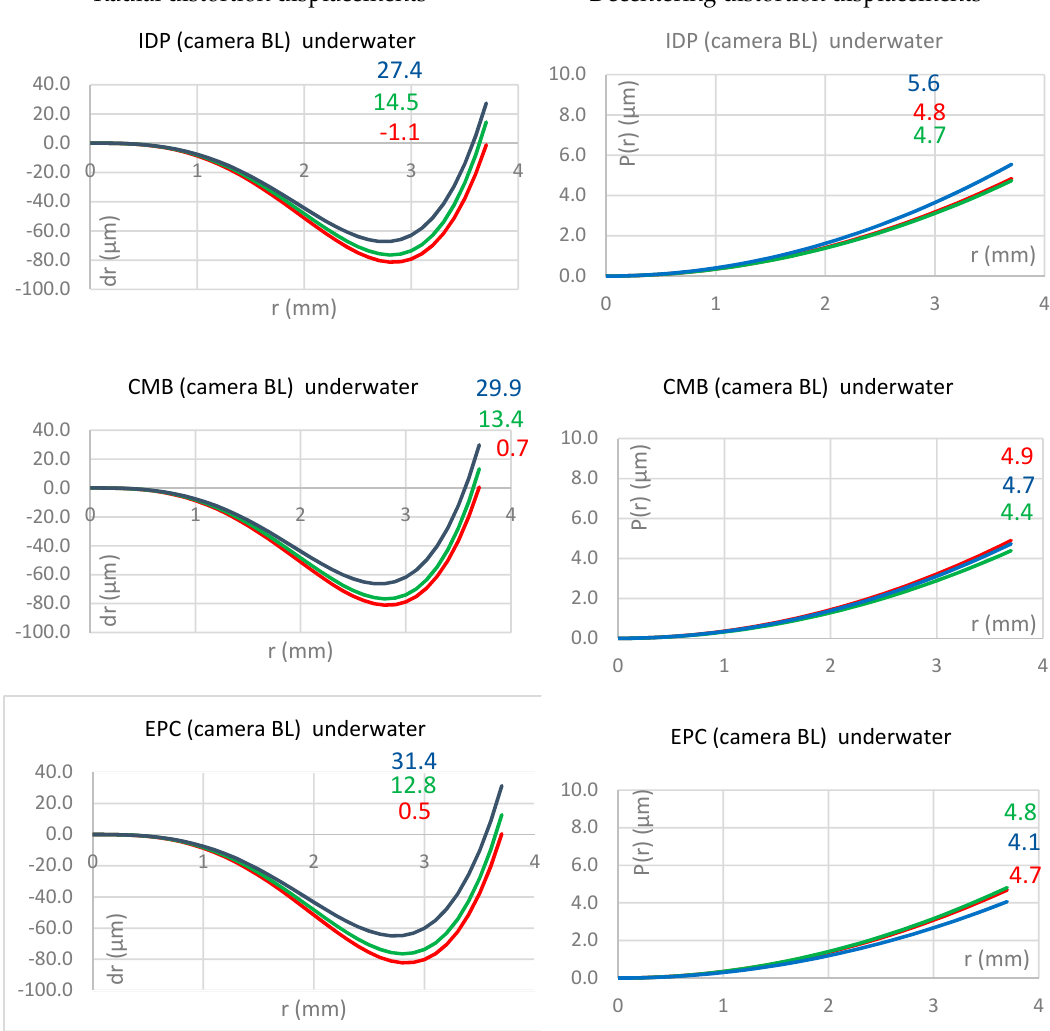
Figure 10. Comparison of the influence of the radial ( right column) and decentering ( left column) lens distortion parameters for three different adjustment constraints (rows) for the camera FL underwater. The colours indicate the results for the different bands (blue, green, red). The numbers indicate the distortion in µm at the maximum radial distance.